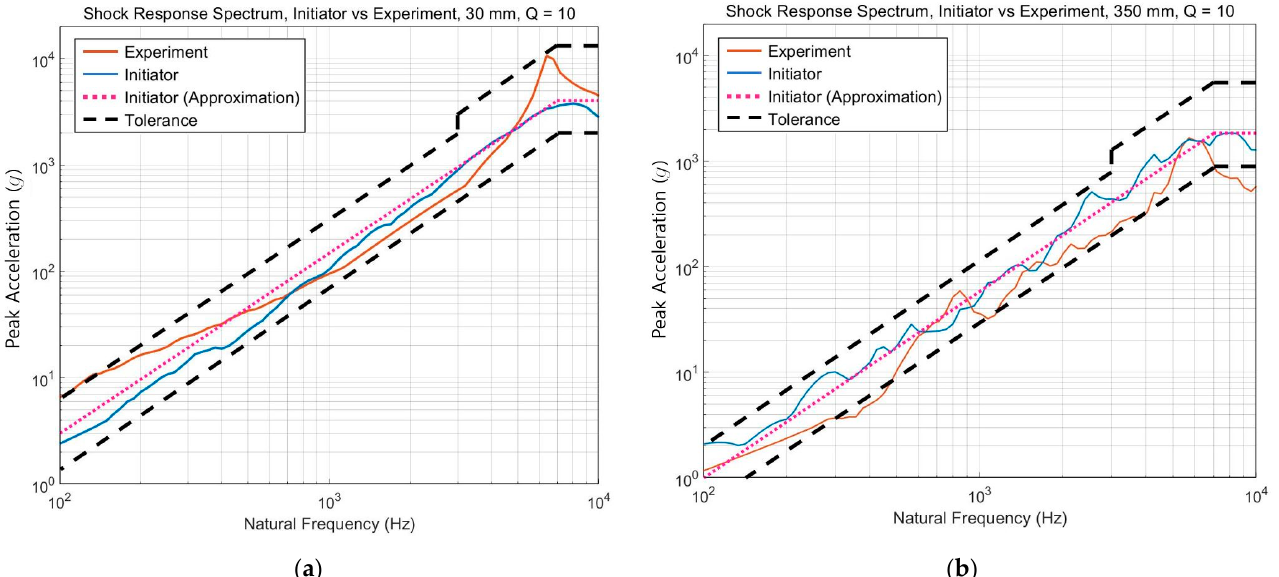
Figure 19. Comparison between pyrotechnic initiator and pyroshock simulator: ( a ) 30 mm position; ( b ) 350 mm position.